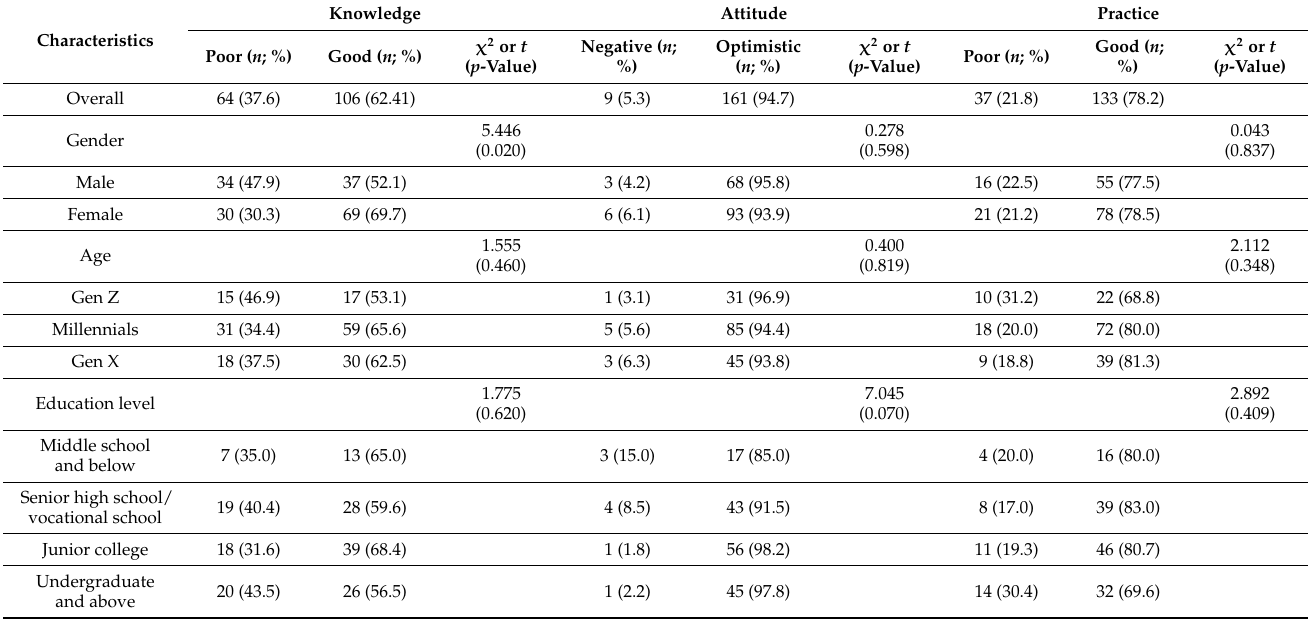
Table 3. Difference in quarantine hotel workers’ KAP toward COVID-19 by demographics ( N =